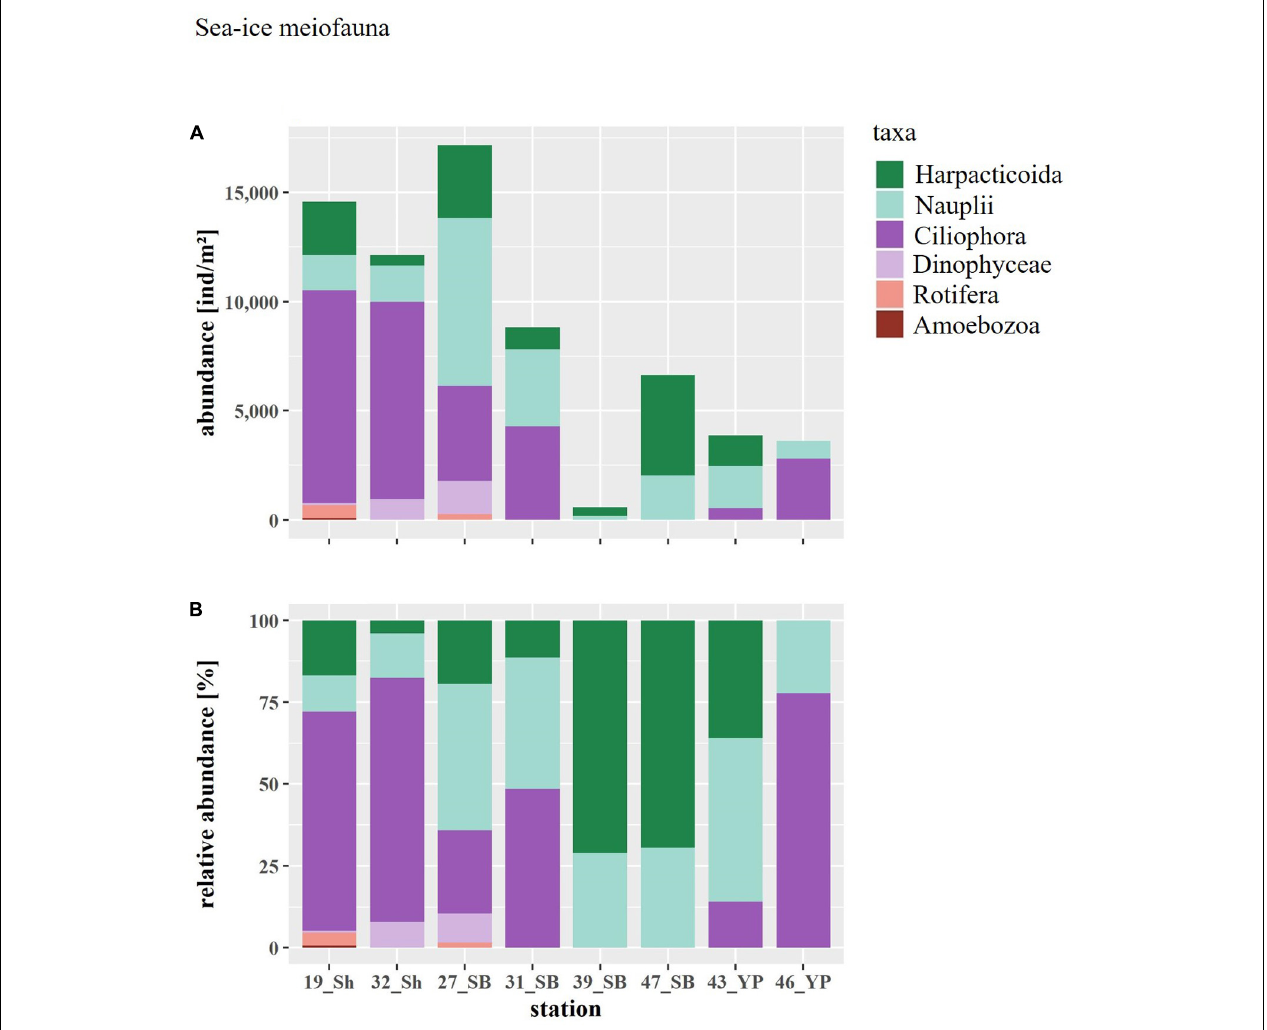
FIGURE 4 | (A) Abundance and (B) relative abundance of the sea-ice meiofauna at ice stations arranged by geographical region (Sh, shelf; SB, Sophia Basin; YP, Yermak Plateau).